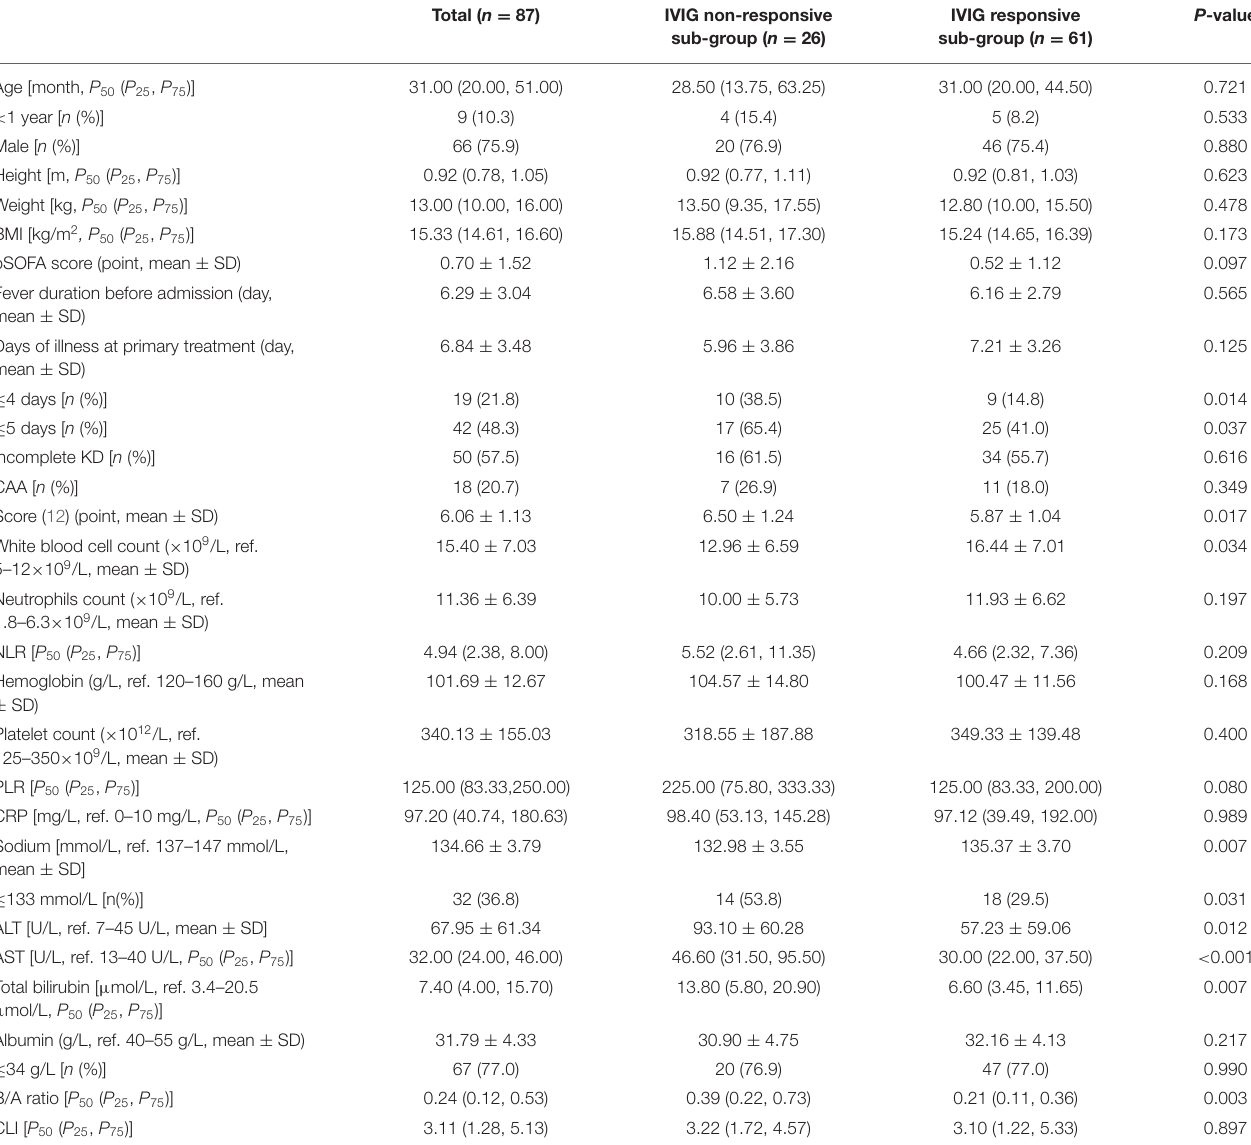
TABLE 1 | Comparison of the baseline characteristics between the intravenous immunoglobulin non-responsive and responsive sub-groups.